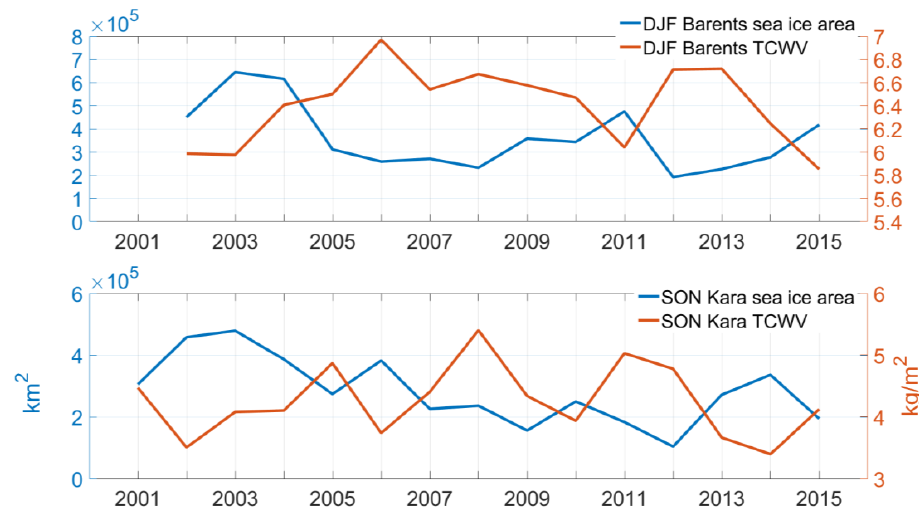
Figure 10. Regionally averaged time series of sea ice area (km 2 ) and TCWV (kg/m 2 ) from 2001 to 2015 in winter (DJF) for the Barents Sea and in fall (SON) for the Kara Sea. Note that TCWV studied regions are defined in Table